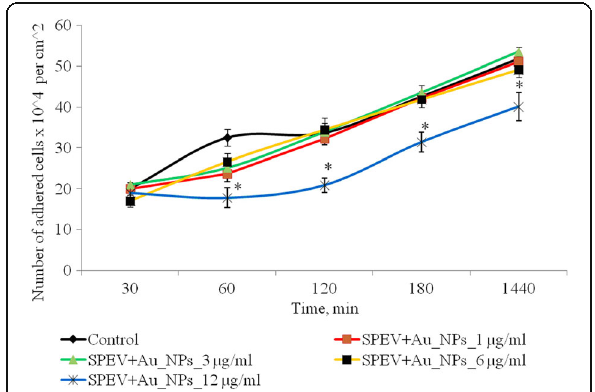
Fig. 2 Dynamics of adhesion of SPEV cells after exposure of AuNPs, * p ≤ 0.05 is significant versus with the